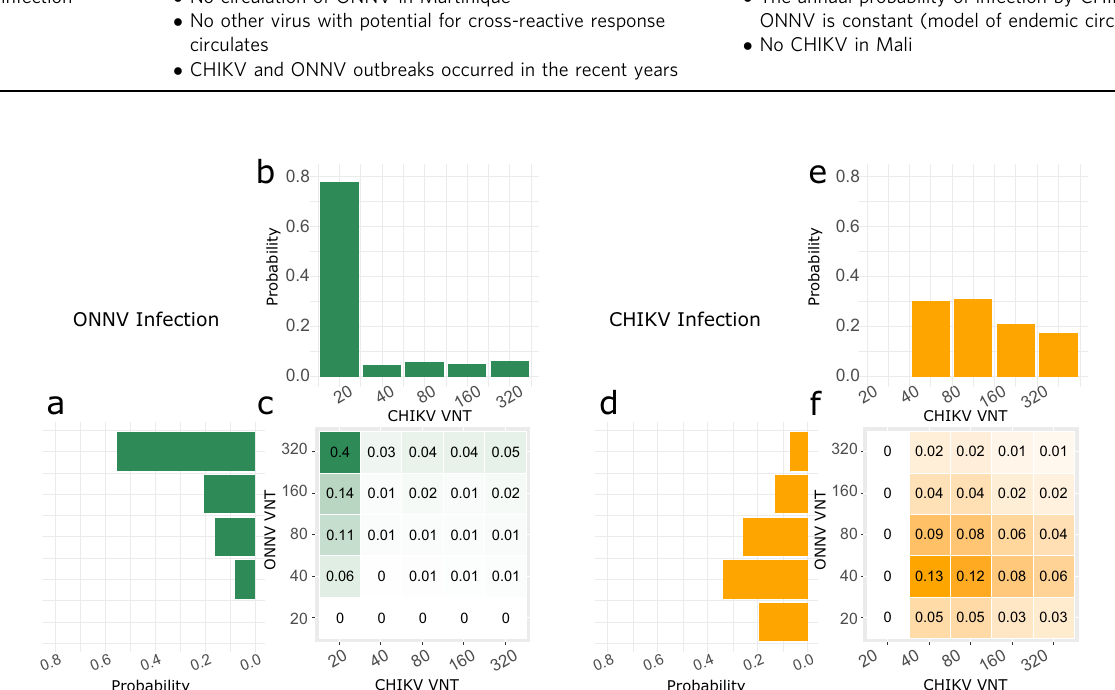
Fig. 2 Response to infection. The heatmaps represent the model estimates of the probability distribution of CHIKV and ONNV neutralization titers (VNT) following an ONNV ( a – c , green) and a CHIKV infection ( d – f , orange). They are the frequencies we would expect from samples obtained in a context where a single pathogen circulated. The histograms are the sum along rows and columns and display the probability distribution of ONNV response ( a , d ) and CHIKV response ( b , e ).